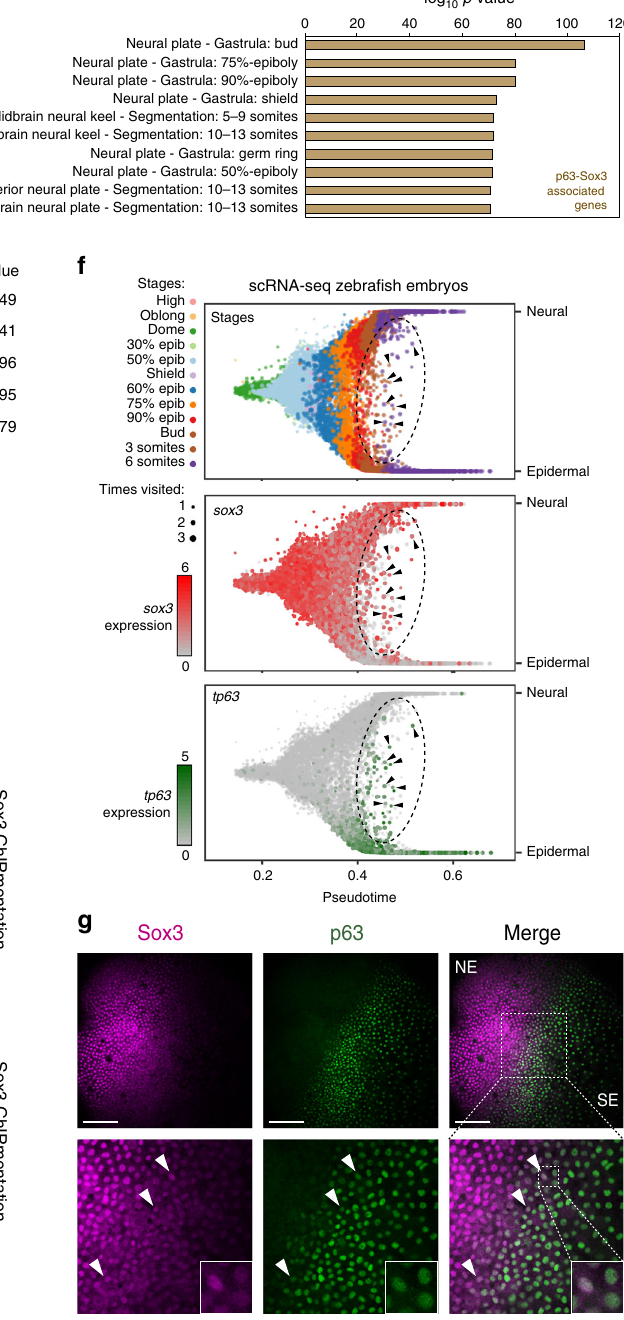
Neural plate - Gastrula: bud Neural plate - Gastrula: 75%-epiboly Neural plate - Gastrula: 90%-epiboly Neural plate - Gastrula: shield Midbrain neural keel - Segmentation: 5–9 somites Midbrain neural keel - Segmentation: 10–13 somites Neural plate - Gastrula: germ ring Neural plate - Gastrula: 50%-epiboly Posterior neural plate - Segmentation: 10–13 somites Hindbrain neural plate - Segmentation: